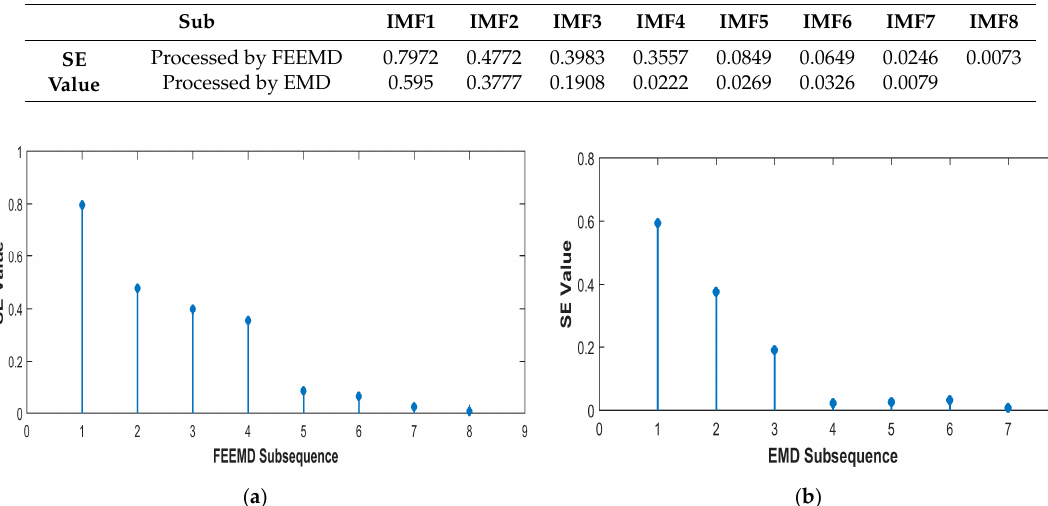
Figure 7. ( a ) The SE value of subsequences processed by FEEMD; ( b ) The SE value of subsequences processed by EMD.